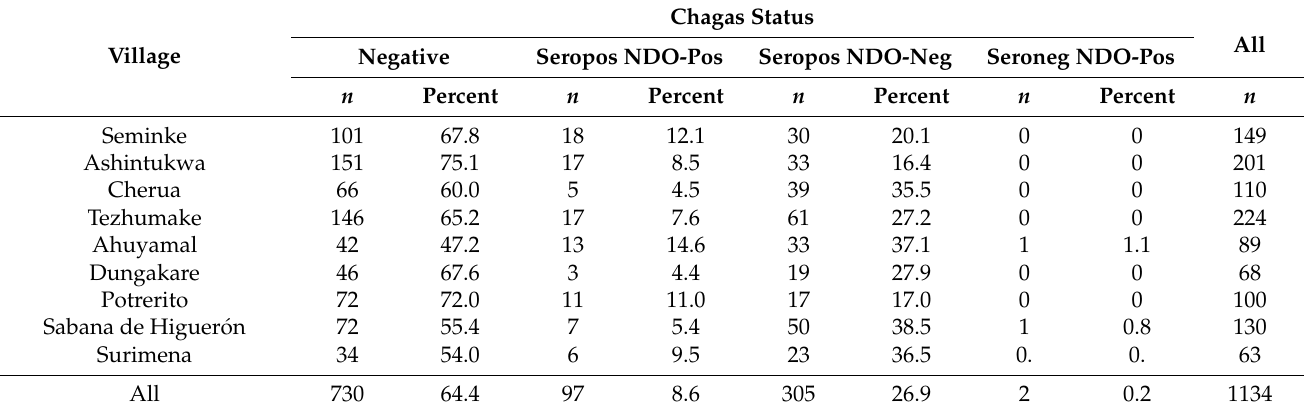
Table 4. Chagas status in the entire study population by village ( n = 1134).